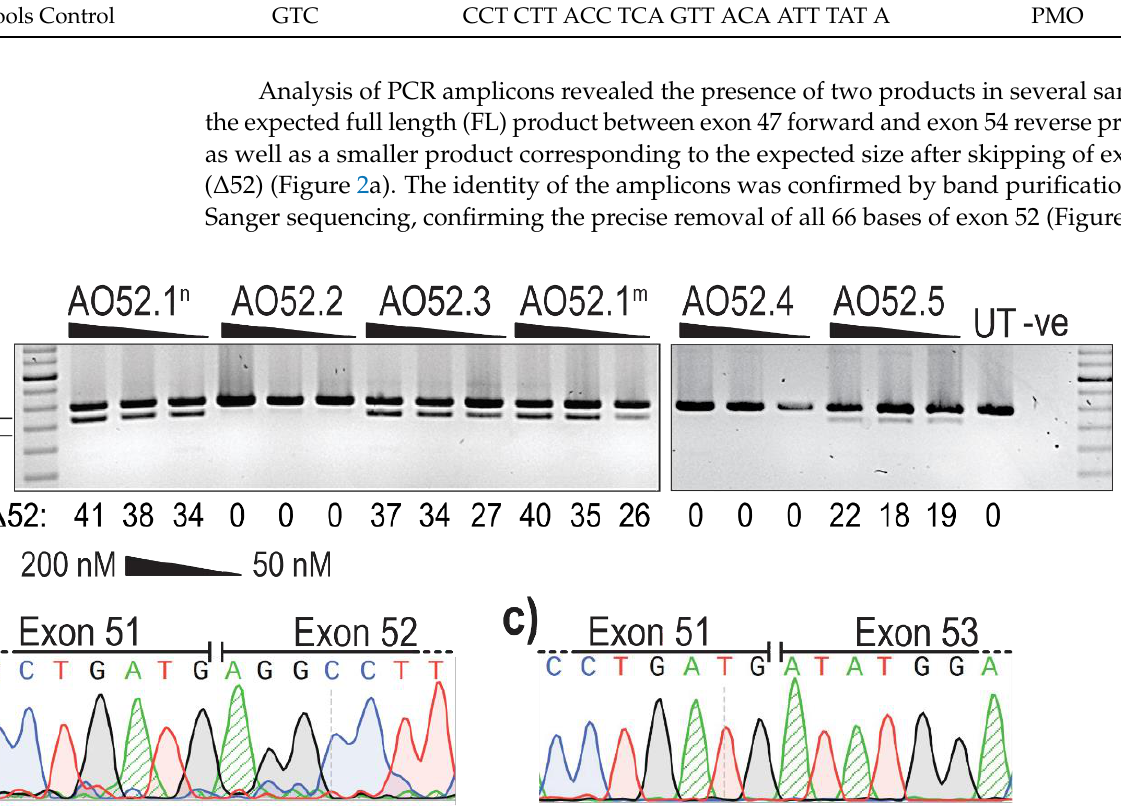
Figure 2. Evaluation of AOs designed to induce FBN1 exon 52 skipping. ( a ) Screening of 2′OMe-PS AOs targeting exon 52. Healthy control fibroblasts were transfected with AOs as lipoplexes at three concentrations, 200, 100 and 50 nM. The values below each gel image indicate the percentage of exon 52 skipped (Δ52) transcripts in each sample. Ctrl: an unrelated sequence used as a sham treatment, UT: untreated control, -ve: RT-PCR negative control. 100 bp molecular marker used for size reference. The gels were cropped for presentation. Full gel images are presented in Figure S1; ( b ) Sanger sequencing analysis showing the junction between exons 51 and 52 in full-length transcripts (FL, 859 bp); ( c ) Sanger sequencing analysis showing the junction between exon 51 and 53 exon 52-skipped transcripts (Δ52, 793 bp).